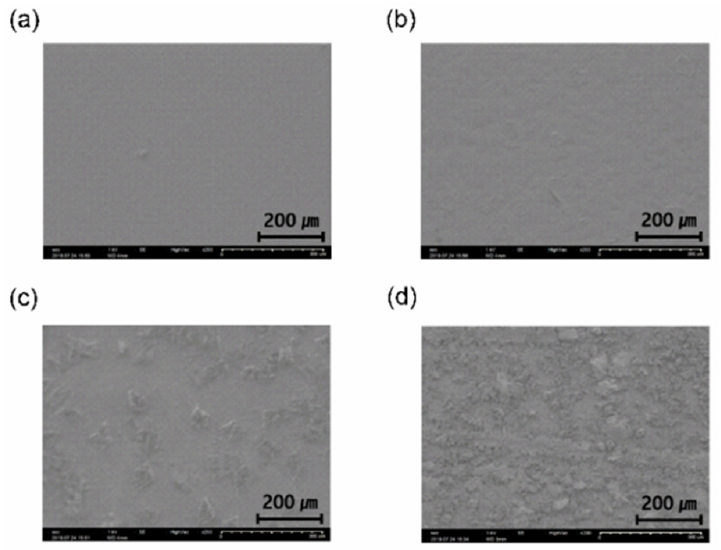
Figure 5. SEM images of the ( a ) P700 ( b ) P500 ( c ) P450 ( d ) P400 parylene films. The P700 and P500 films are polymerized films with flat surfaces due to the high cleavage rate of the parylene dimers into monomers (a polymer). However, in the P450 and P400 films, randomly distributed dimer crystals can be seen due to the low dimer-cleavage rate. It was also demonstrated that the density of the dimer crystals on the surface of the P400 film was more than that of the P450 film. The surface image of the 30 µ m × 30 µ m area of the parylene films is further analyzed through AFM images, as shown in Figure 6.